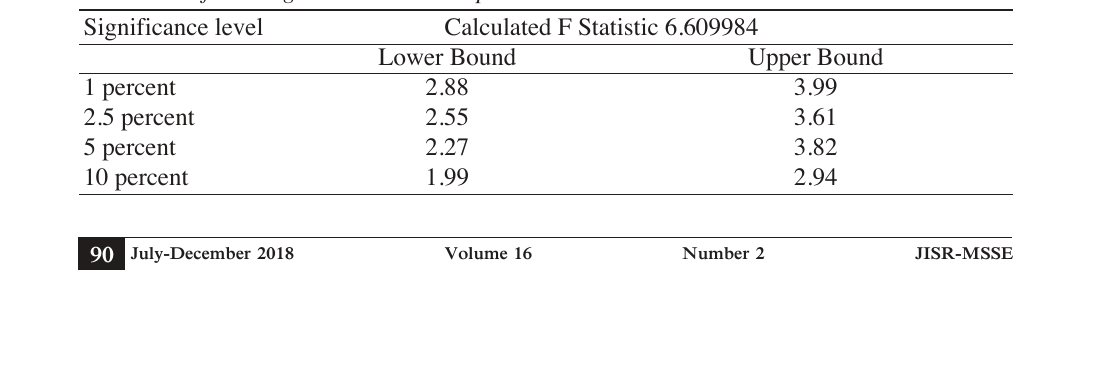
F-statistic of Cointegration